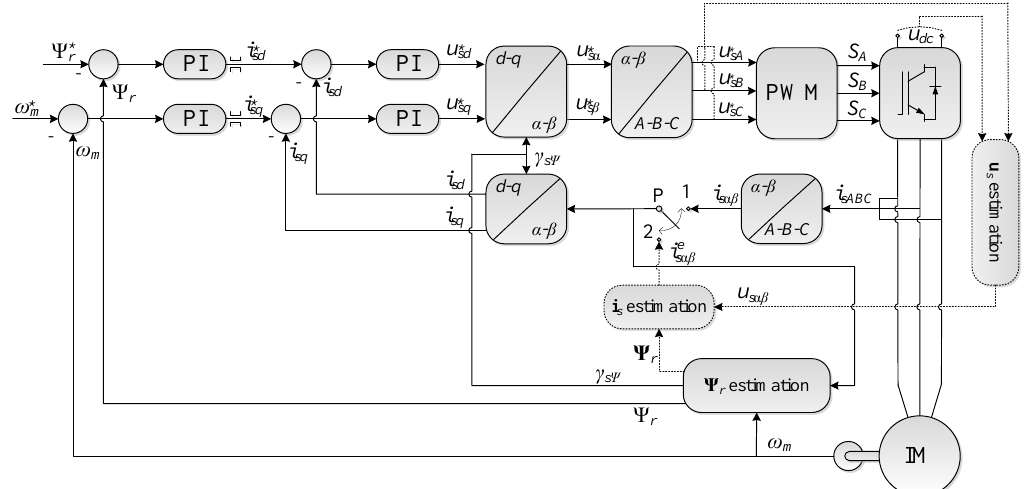
Figure 2. DRFOC structure with the ability to work without measuring phase currents: switch P in position 1 — classical structure; switch P in position 2 — structure with phase current estimation.